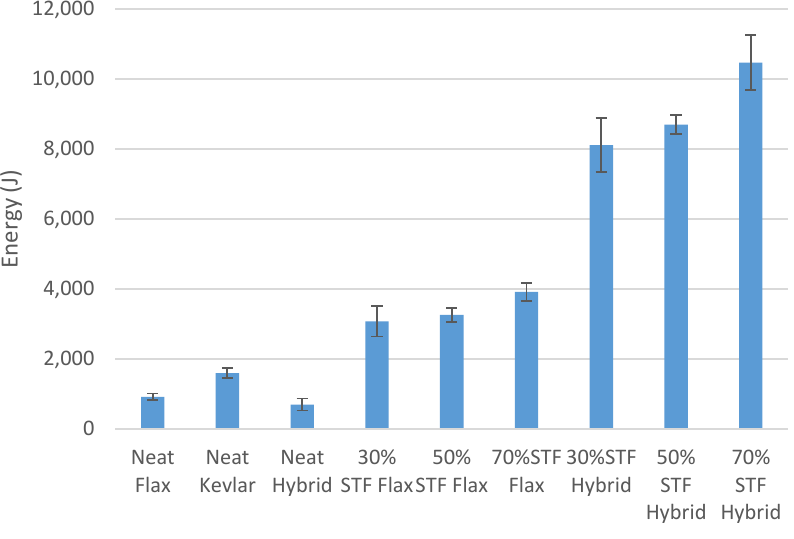
Figure 8. Comparison of average energy absorbed during puncture testing.